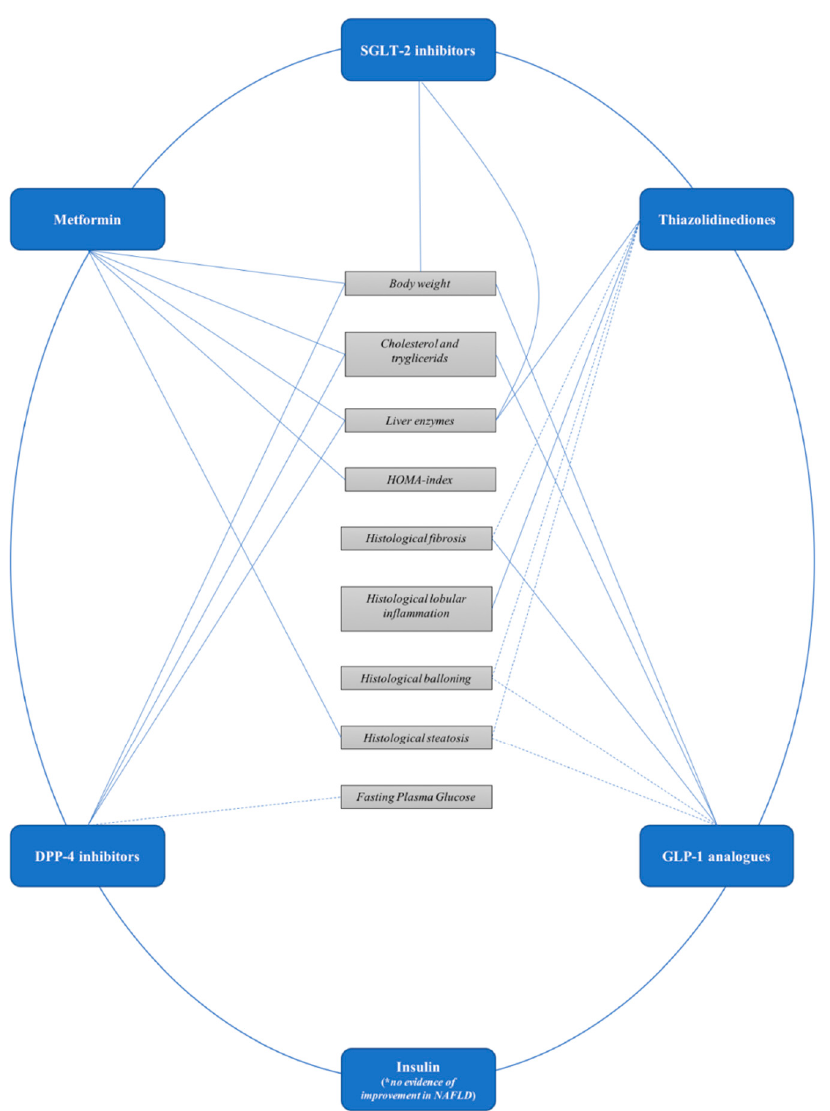
Figure 1. Effect of antidiabetic drugs on metabolic and liver outcomes in patients with non-alcoholic fatty liver disease. SGLT-2: sodium-glucose cotransporter 2; DPP-4: Dipeptidyl peptidase-4; GLP-1: Glucagon-like pepide-1.